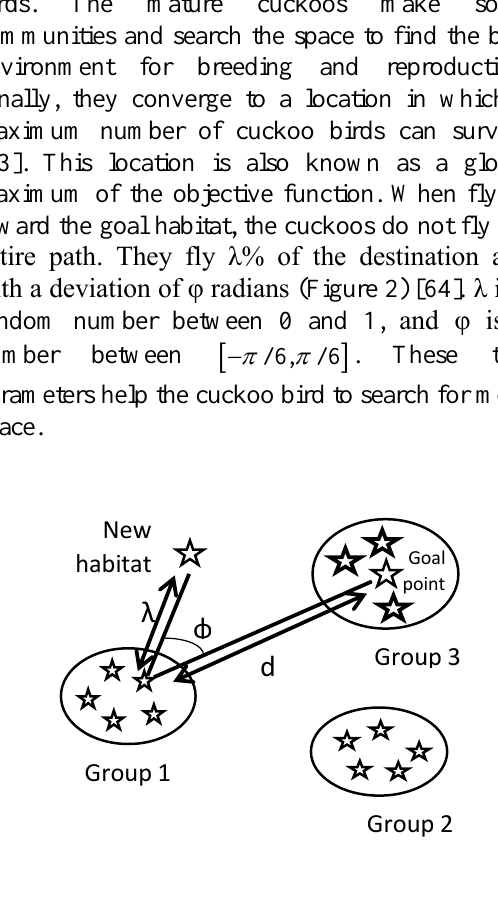
Figure 2. Movement of a cuckoo toward goal habitat